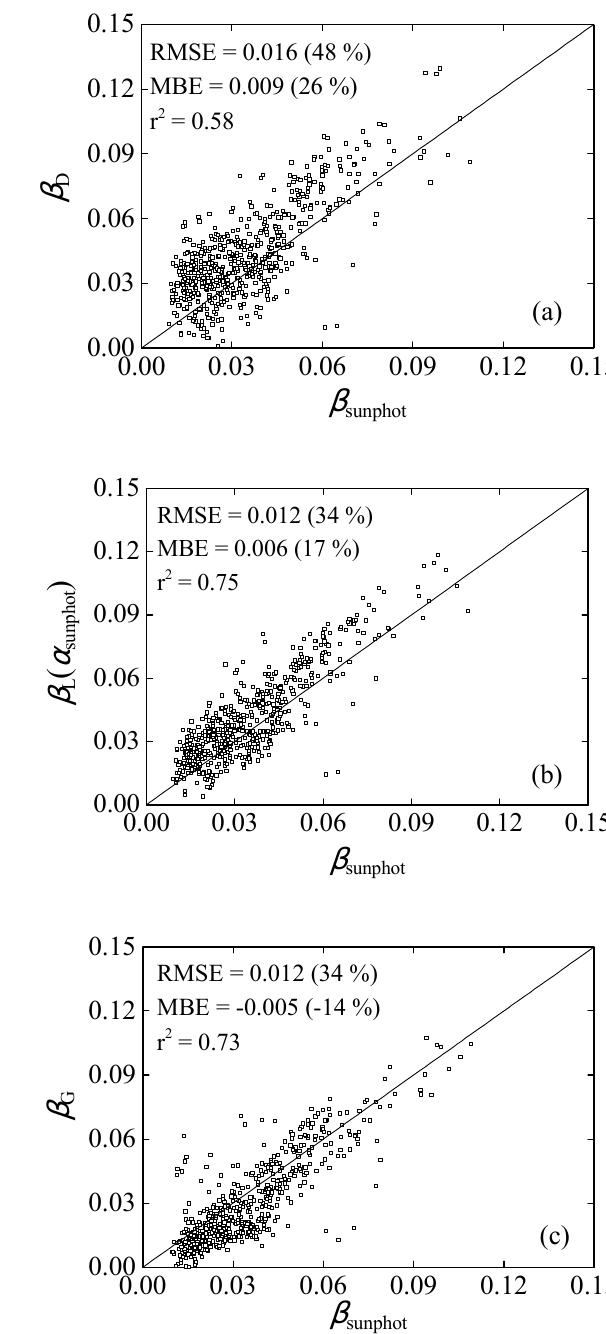
Fig. 7. Hourly turbidity estimates by using Dogniaux’s (a) , Louche’s (b) and Gueymard’s (c) algorithms versus turbidity val- ues derived from sunphotometric measurements at Bondville ( β L was calculated employing values of α obtained from sunphotomet- ric